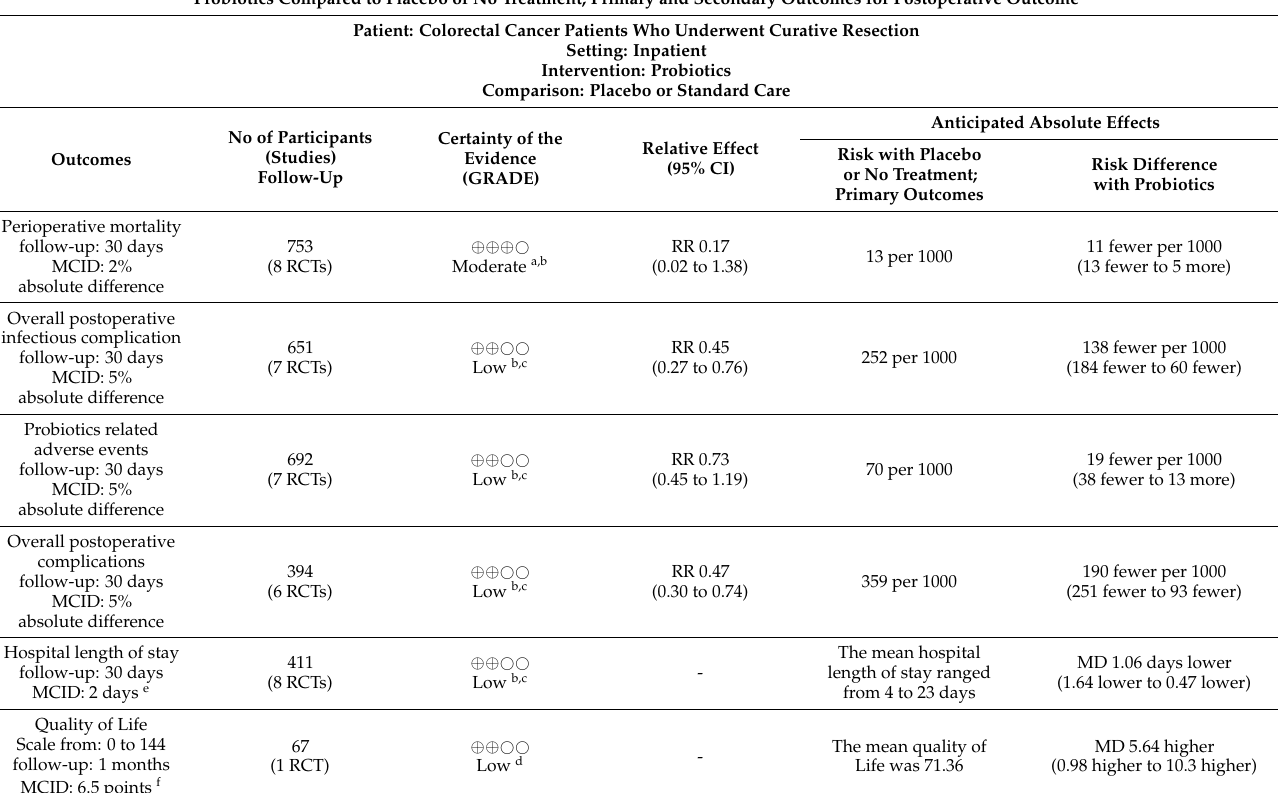
Table 2. Summary of